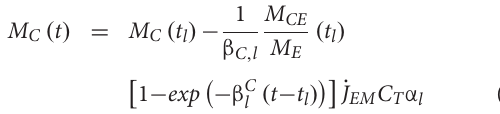
( Supplementary Figure A.1 ), and the model performance for fatty acid and amino acid dynamics in the absence of